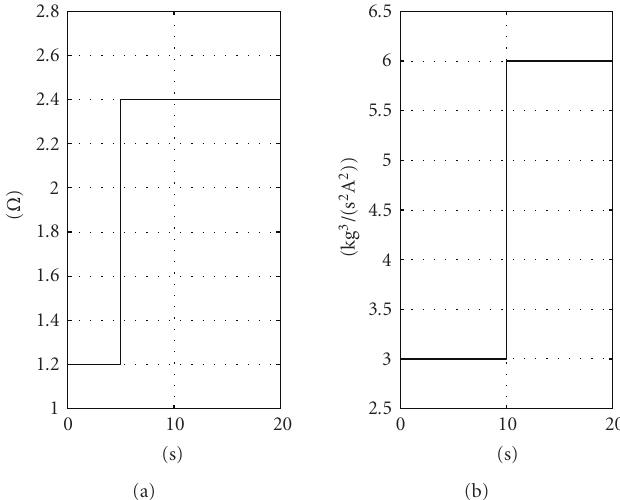
Figure 6: (a) Resistance variation, (b) magnetic constant variation.